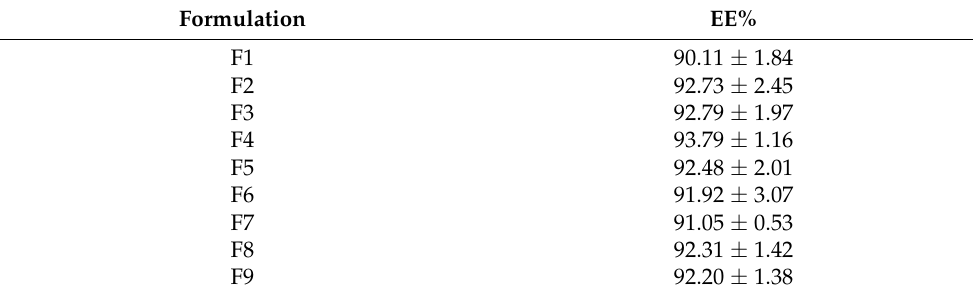
Table 2. The EE% values of the produced formulations.